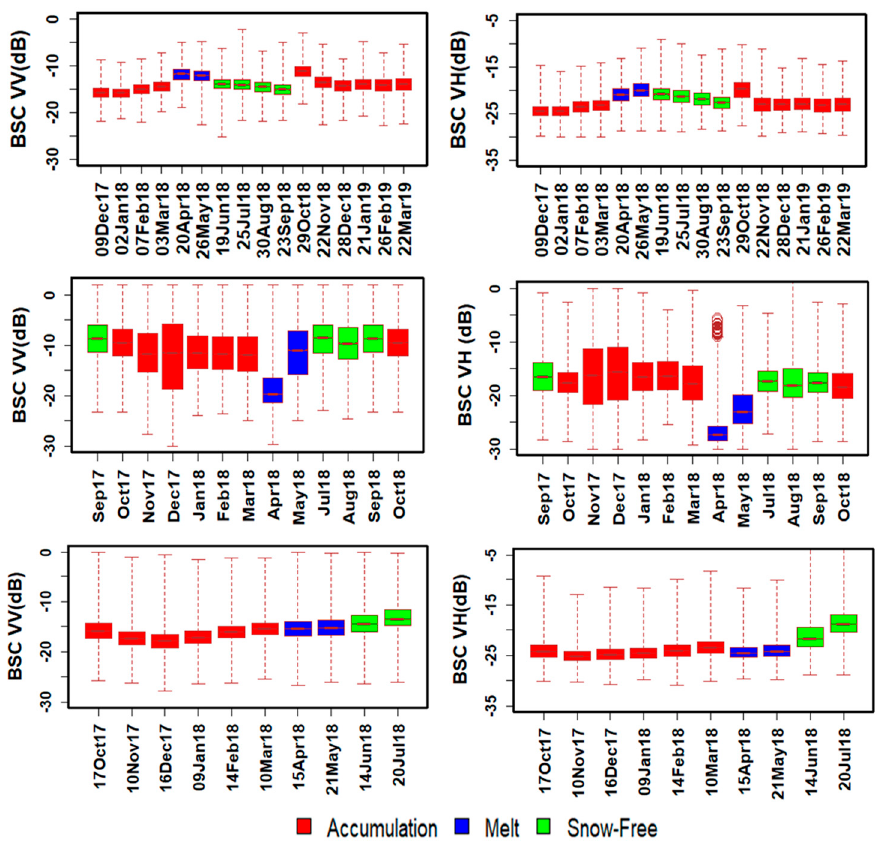
Figure 9. Variation of multi-temporal backscattering coefficients VV (right) and VH(left) over Grand Mesa (top, grassland area A), Swiss Alps (middle) and North Dakota (bottom) over 4 × 4 km 2 . The thick horizontal line in the center of the solid box represents the median, the vertical dimension of the box is indicative of the first quartile (horizontal bottom line) and the third quartile (horizontal top line), and the vertical dashed line indicates the range (minimum and maximum values) of the data.